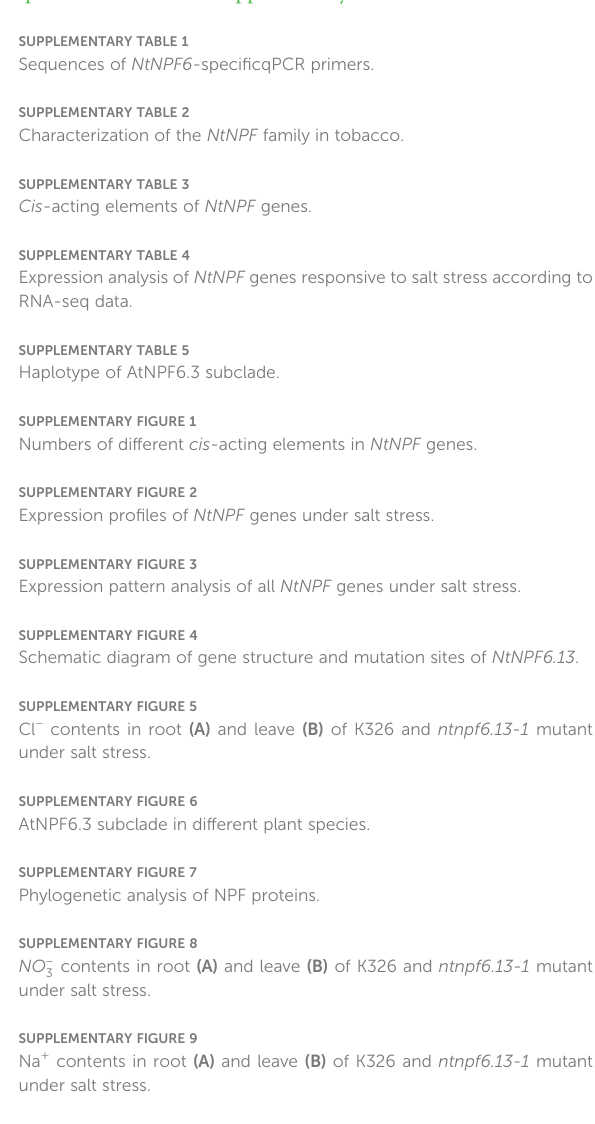
ntnpf6.13-1 mutant